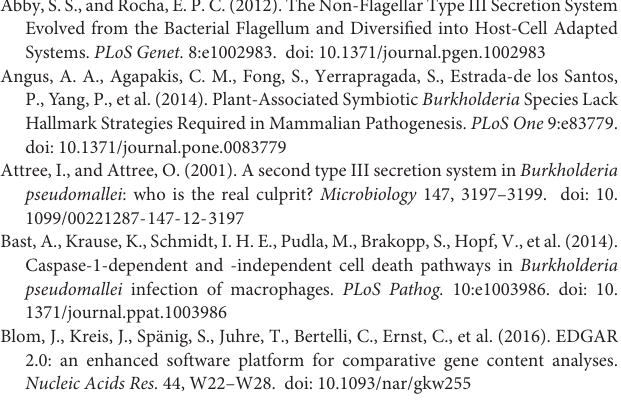
Supplementary Table 3 | Bacterial strains and plasmids used in this study. Supplementary Table 4 | T3SS repartition within Burkholderia s.l. strains. Supplementary Table 5 | Intraspecific diversity of T3SS distribution for a selection of ten species. Supplementary Table 6 | Curated list of candidate effectors in Burkholderia s.l.